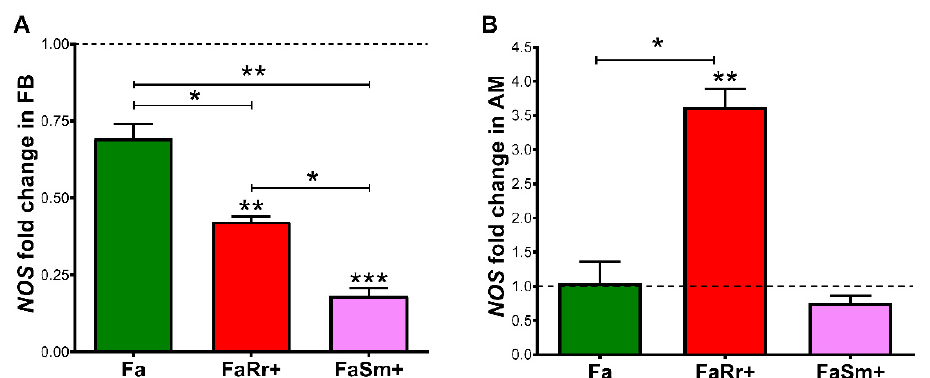
Figure 7. Nitric oxide synthase ( NOS ) relative expression in fat bod (FB) ( A ) and anterior midgut (AM) ( B ) of 5th instar nymphs of Rhodnius prolixus 7 days after feeding. The insects were previously treated with antibiotics as 4th instar nymphs and recolonized with Rhodococcus rhodnii or Serratia marcescens added to the blood meal of 5th instar nymphs. The treatments and group names are as described in Figure 1 Each bar represents the mean of relative quantification (RQ) values of 2 experiments, each with 2 pools of 5 insect tissues, with a total of 20 insects ( n = 4). The relative quantification by the ΔΔ Ct method was performed using the control group (insects fed with blood only) as the calibrator. ΔΔ Ct values were analyzed by one-way ANOVA with the post-hoc Tukey test, * p < 0.05; ** p < 0.01; *** p < 0.001. The level of expression of the control group (arbitrarily set as 1) is shown with the dotted line. Asterisks above individual bars show significant differences to the controls, and asterisks above brackets show differences between two experimental groups.